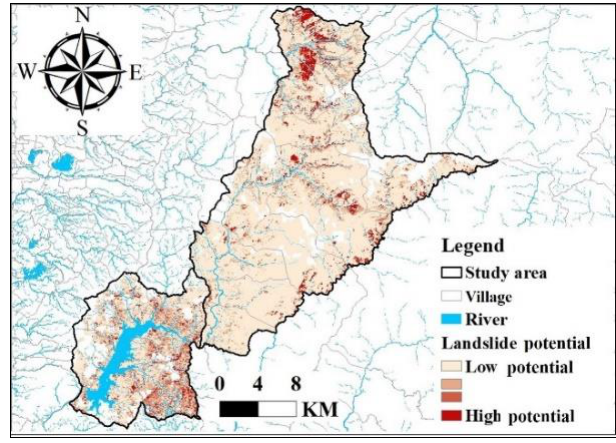
Figure 8. Postrainfall earthquake-induced landslide potential.